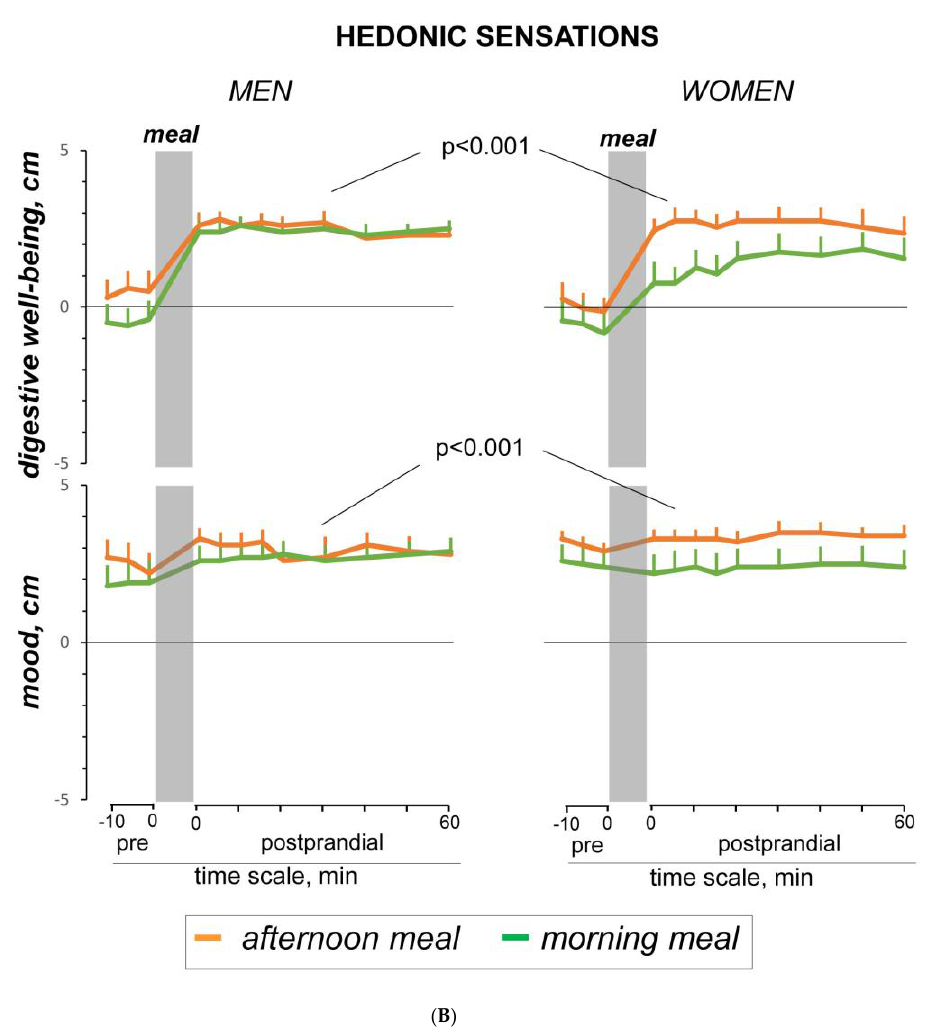
Figure 1. The effect of ingestion time on the postprandial experience. ( A ) Homeostatic sensations. ( B ) Hedonic sensations. Perceptions measured on 10-cm scales before ( − 10 to 0 minutes) and after (0 to 60 minutes) the meal; ingestion time 12 min. In women, the sensory experience induced by the probe meal, particularly postprandial satisfaction, was weaker when eaten at an unconventional time for breakfast. The effect of meal schedule was more pronounced in women than men. The main gender effect by repeated measures ANCOVA is shown. Dependent variable: postprandial scores. Covariate: pre-meal